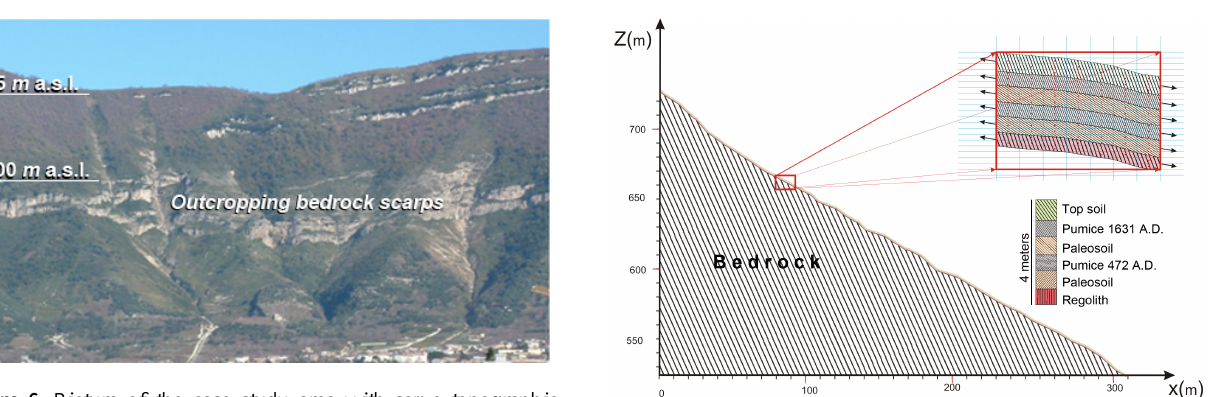
Figure 6. Picture of the case study area with some topographic details. Figure 7. Geometric and stratigraphic characterization of the inves- tigated